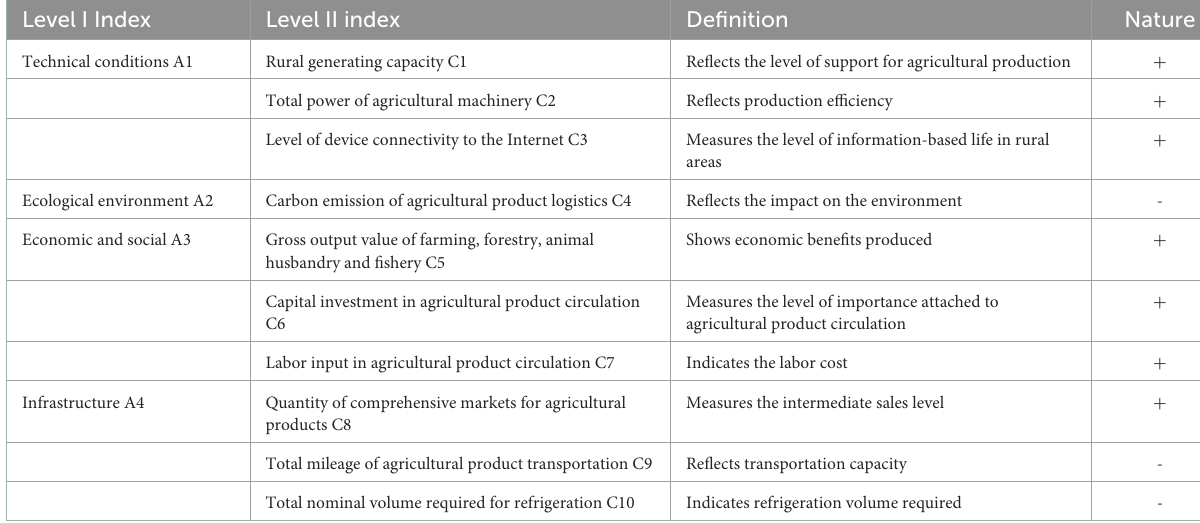
TABLE 1 Indexes, and their definition and